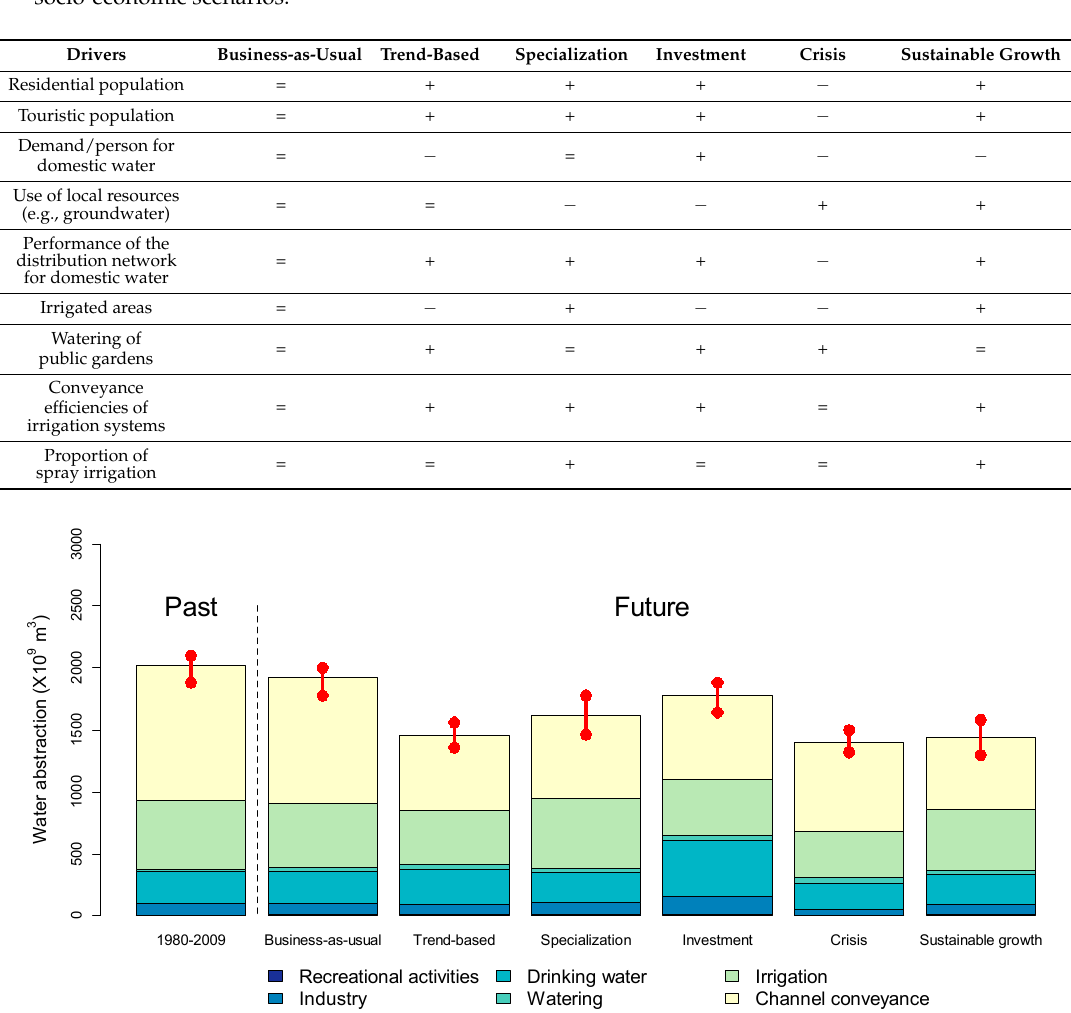
Table 1. Sign of the change in the drivers of water demand with respect to 2010, considered in the six socio ‐ economic scenarios.